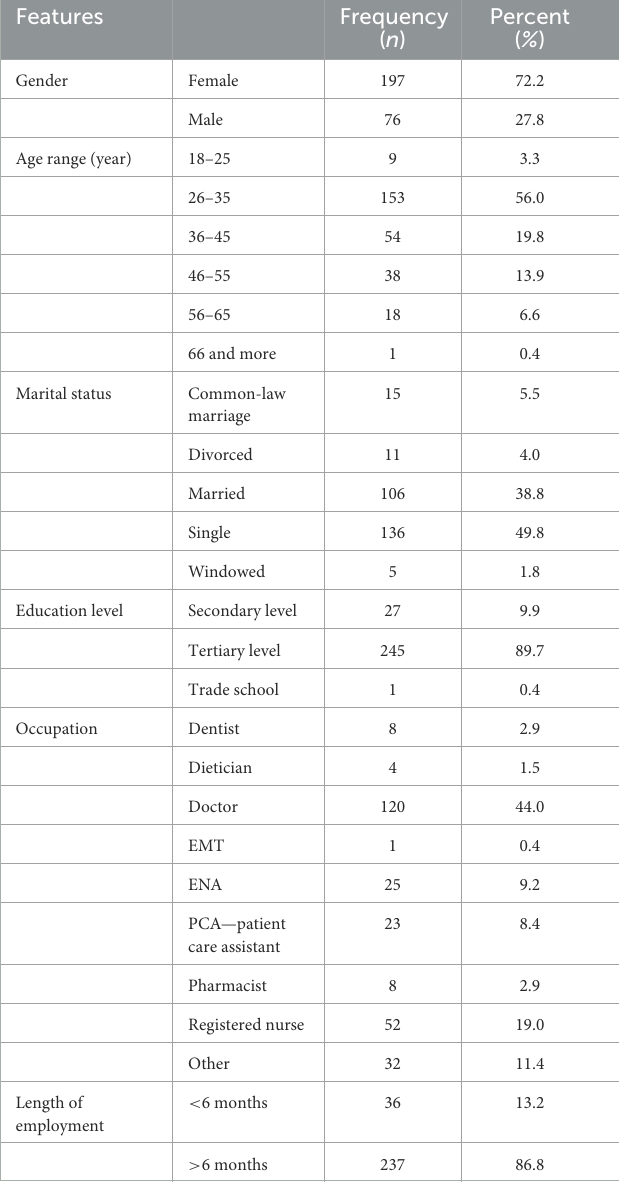
TABLE 1 Demographic features of the participants ( n =